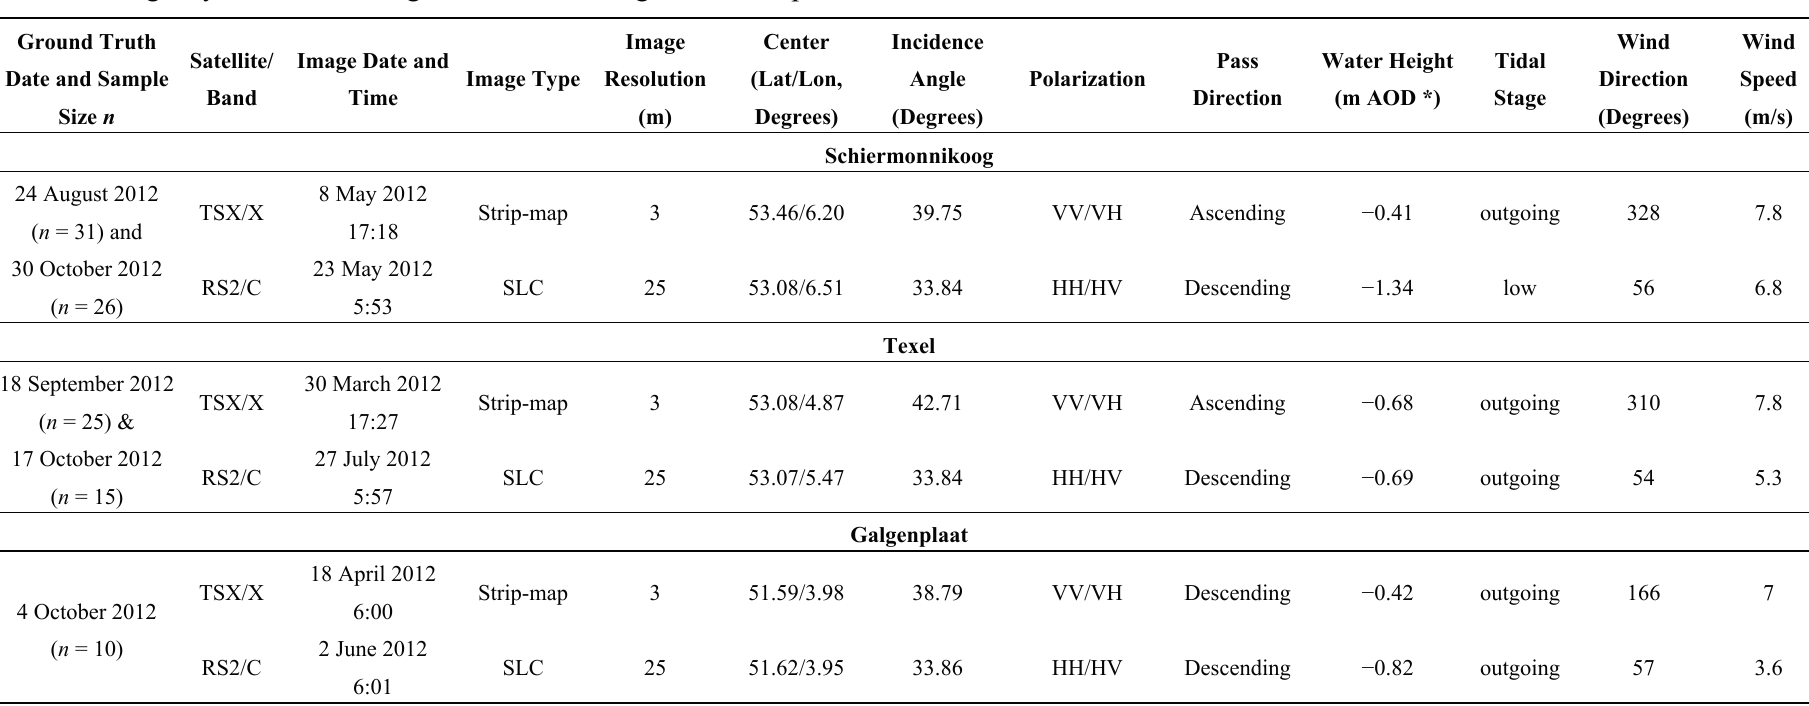
Table 1. Specification of the different SAR scenes, the local prevailing conditions and matching field campaigns. The weather conditions were acquired from the Royal Netherlands Meteorological Institute (KNMI). Information on tidal conditions was provided by Rijkswaterstaat, the Dutch agency for water management. SLC is single look